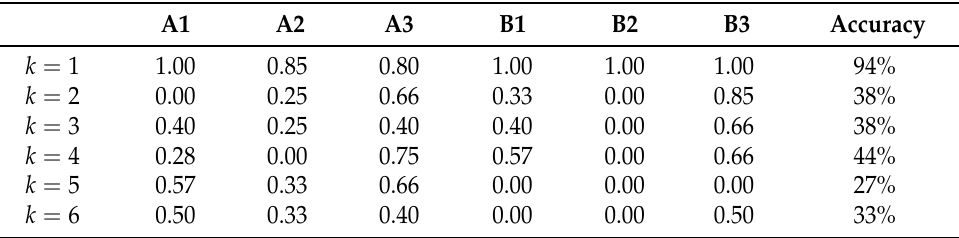
Figure 1. The confusion matrices for the results of classification based on KNN, when k = 1, k = 2, k = 3, k = 4, k = 5, and k = 6 are in ( top-left ), ( top-right ), ( middle-left ), ( middle-right ), ( bottom-left ), and ( bottom-right ), respectively. Table 1. The results of F -scores for the validity set under different values of k